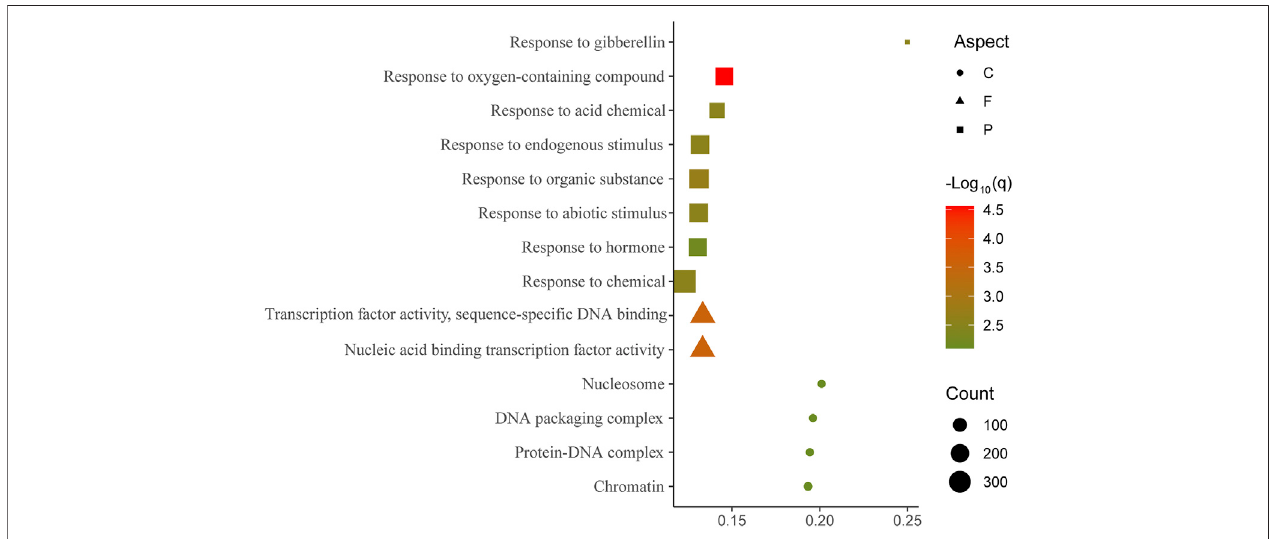
FIGURE3| Geneontology(GO)enrichment fi ndingsofgeneswith100%oftransmittedSNPsfromgenomictotranscriptionallevelinZS11Falsediscoveryrate(q)ofall (cid:129) cellular component (C); ▲ molecular function(F); ■ biological process (P). Larger symbols indicate increased gene expression levels. the enriched GO terms was < 0.01.